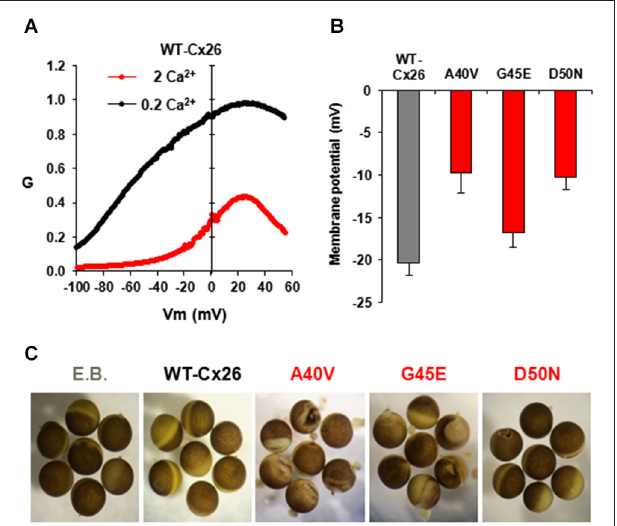
FIGURE 4 | HC activity in Xenopus oocytes injected with WT and mutant Cx26-mRNAs. (A) Normalized G-V relationships of WT Cx26 HCs at two different external Ca 2 + concentrations, 0.2 and 2 mM. Data were obtained by applying slow (600 s) voltage ramps from +60 to − 100 mV from a holding potential of − 20 mV. Ramps were obtained for each oocyte in 0.2 and 2 mM Ca 2 + and normalized to the maximum value measured in 0.2 mM Ca 2 + . In WT Cx26, increasing Ca 2 + shifted activation in the depolarizing direction and suppressed current magnitude. Adapted from (Sanchez et al., 2013). (B) Plot showing resting membrane potentials measured in oocytes 24–48 h after injection of RNA for WT-Cx26 and A40V, G45E and D50N mutants. Adapted from (Sánchez et al., 2010). (C) KID syndrome mutant HCs induce different degrees of cell damage in oocytes 4 days after RNA injection. As a control, oocytes were injected with elution buffer, E.B. (RNA vehicle). Oocytes expressing A40V, in particular, as well as G45E exhibit widespread disorganization of pigmentation and blebbing of the membrane. D50N exhibits delayed blebbing and cell